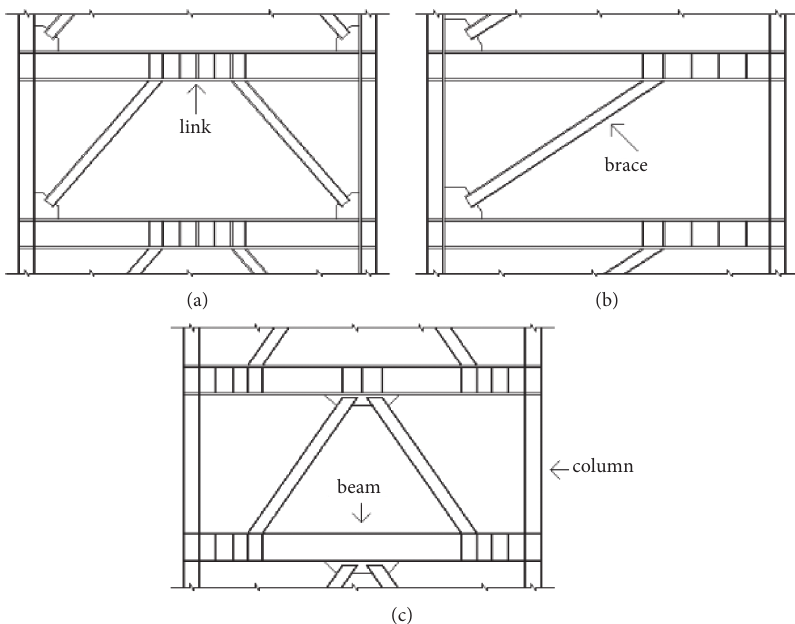
Figure 2: Several schematic models of various structural member arrangement models in frames with eccentric bracing systems